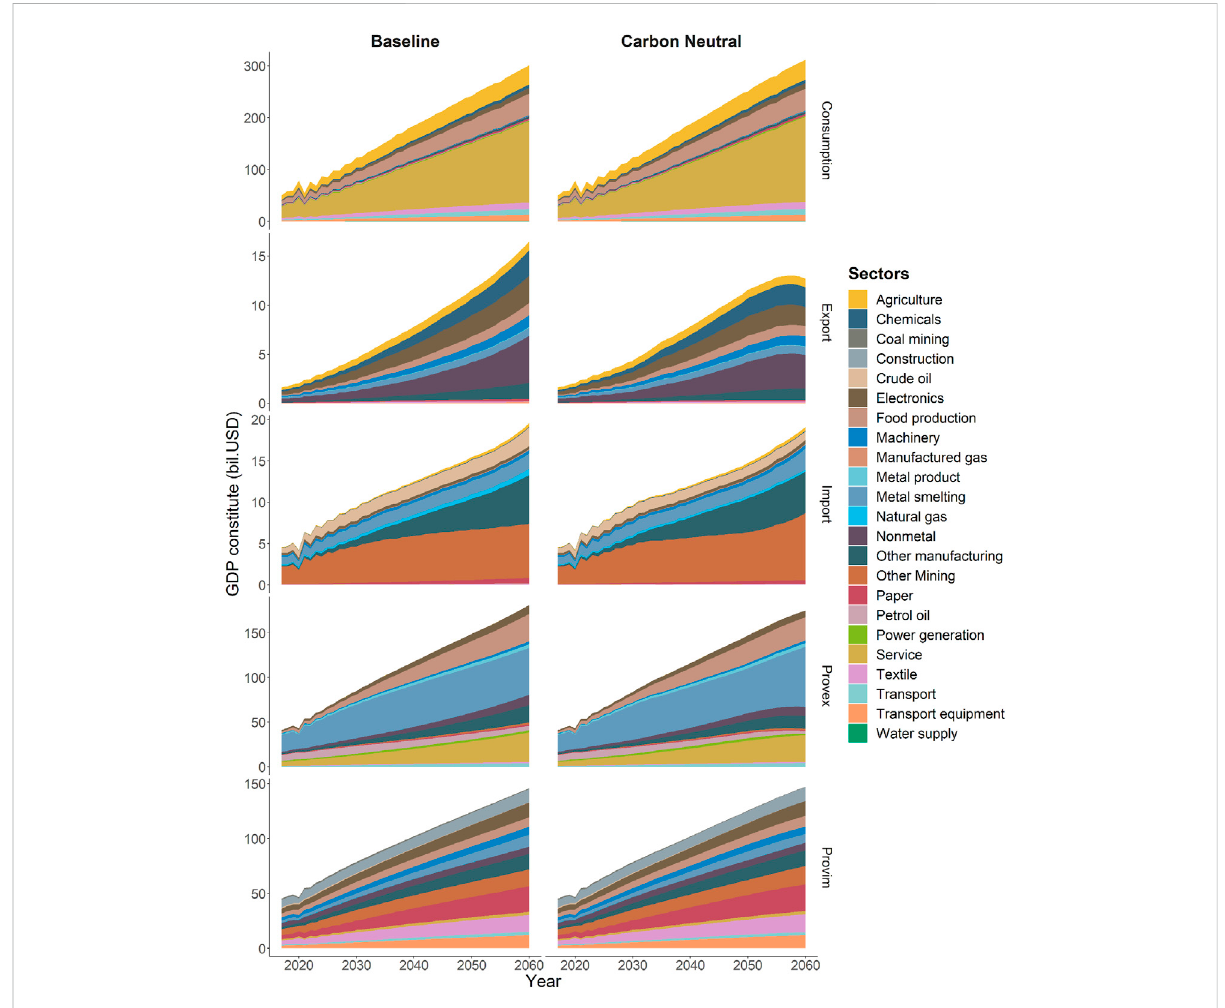
FIGURE 6 Economic output by sector in baseline and carbon neutral scenario from 2017 to